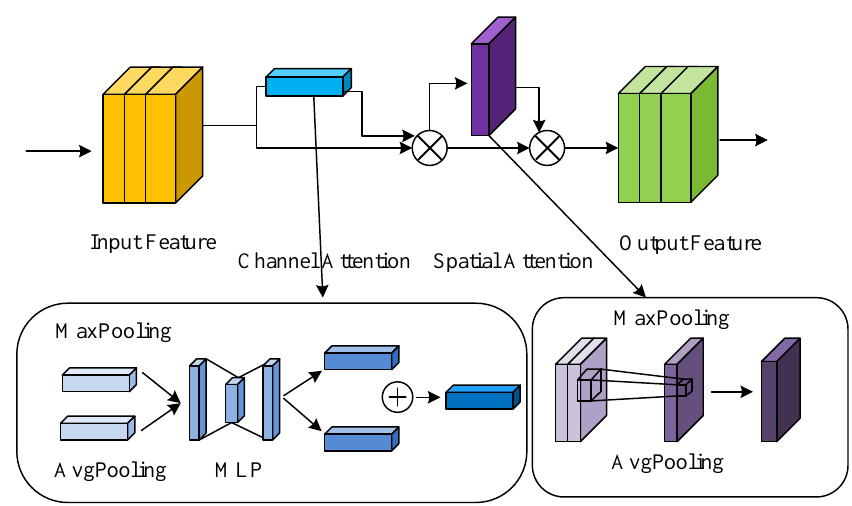
Figure 4. The structure of the CBAM